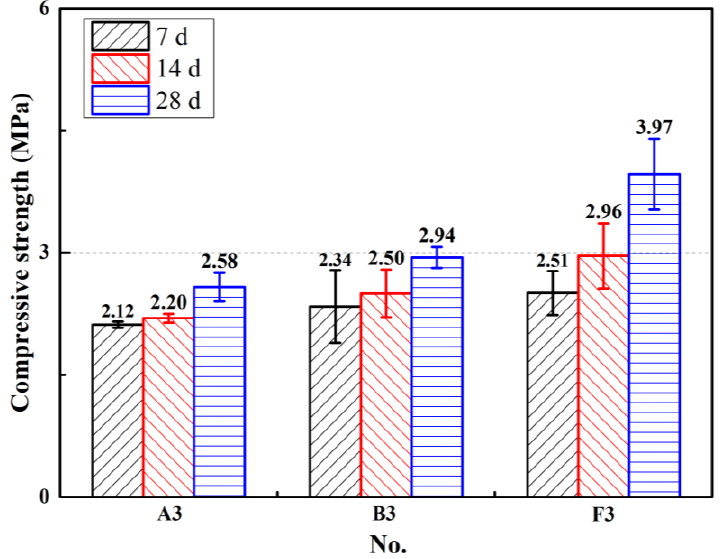
Figure 5. Compressive strength of specimens when water-to-binder ratio is 3.